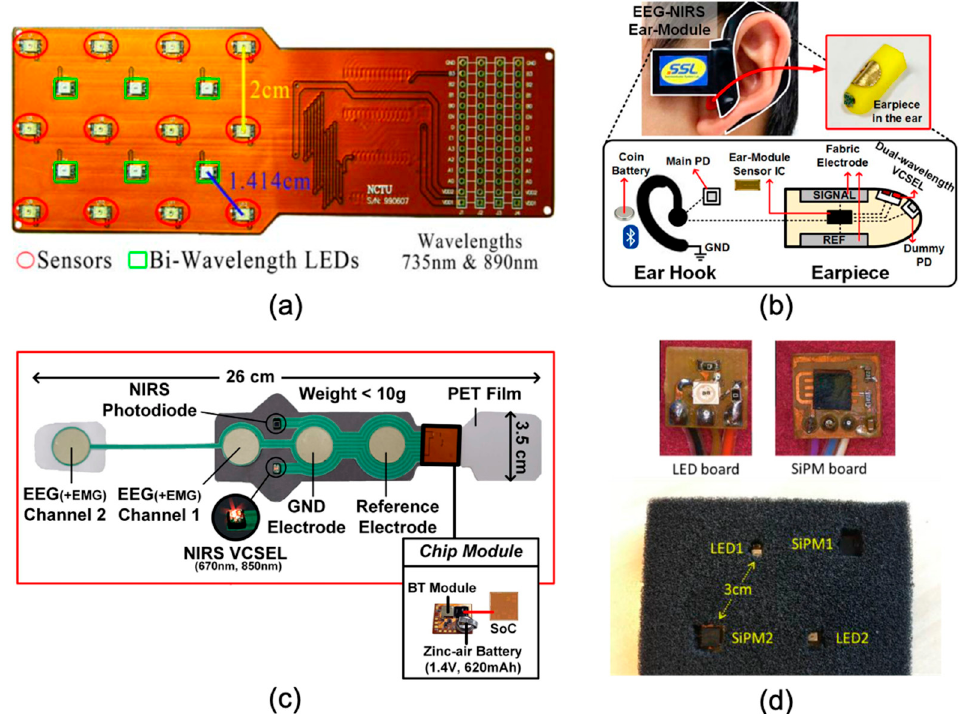
Figure 2. Examples of microchip-based technologies. ( a ) The CMOS-based integrated EEG–fNIRS system developed by Chua et al. This system uses a bendable PCB to house 6 dual-wavelength LEDs and 12 detectors. This figure was taken with permission from [44]. ( b ) The SoC-based EEG–fNIRS ear-module system. The SoC, source, and electrode are embedded in an earpiece while the main photodiode, battery, and Bluetooth module are located at an ear hook. This figure was taken with permission from [45]. ( c ) The integrated EEG–fNIRS system for anaesthesia depth monitoring developed by Ha et al. The SoC with Bluetooth module and battery are embedded on a flexible PCB section and a polyethylene terephthalate (PET) film is fabricated to house the sources, detectors, EEG electrodes, and accessory components. This figure was taken and modified with permission from [46]. ( d ) The CMOS-based integrated multimodal EEG–fNIRS–EIT systems developed by Xu et al. A dual-wavelength LED is employed as an optical source, and a SiPM is utilised as an optical detector. This figure was taken with permission from [47].